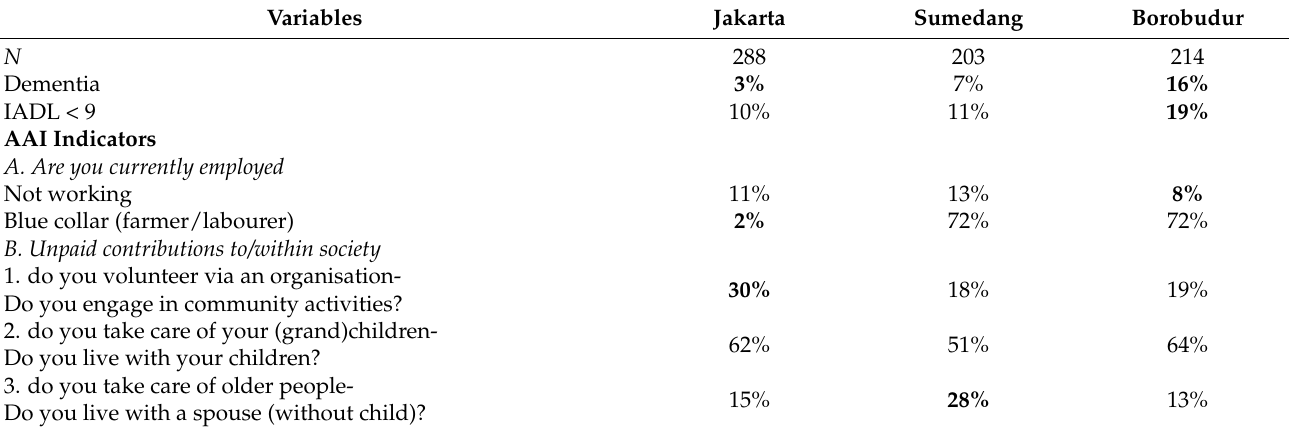
Table 3. Proxy indicators of the Active Ageing Index and outcomes over different sites/districts. Bold indicate differences between